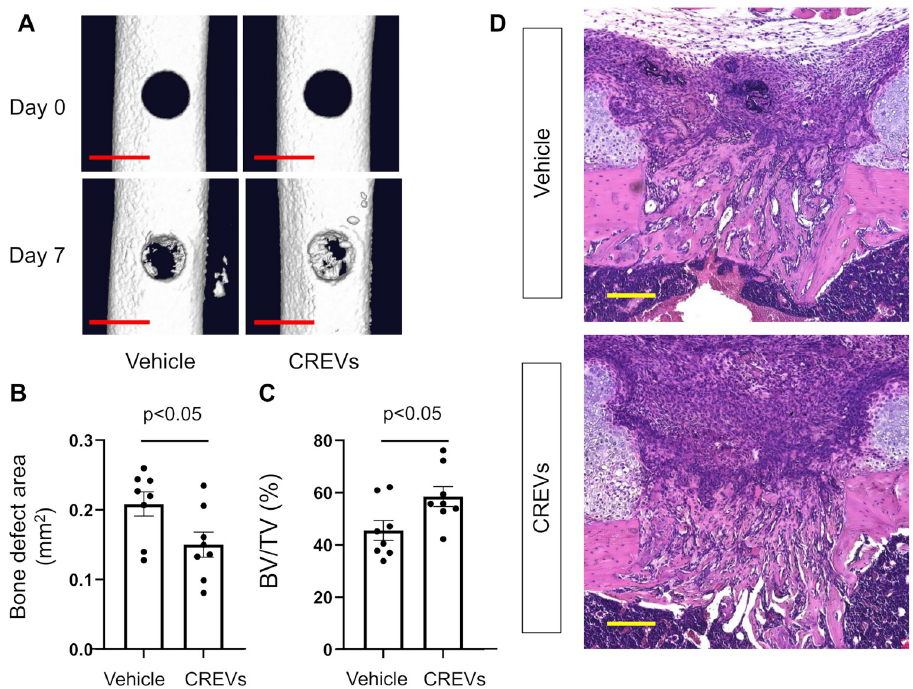
Fig 2. Effects of the local administration of CREVs on bone repair after a femoral bone defect. (A) Three- dimensional qCT images of damaged sites 7 days after a femoral bone defect. The scale bar indicates 1 mm. (B) The bone defect area at the damaged site 7 days after the femoral bone defect. (C) The bone volume/tissue volume (BV/TV, %) of mineralized bone that formed in the hole region 7 days after the femoral bone defect. Results are expressed as the means ± SEM of 8 mice per group. Statistical analyses were performed using the Mann–Whitney U test (B, C). (D) Images of HE-stained sections of damaged sites 7 days after the femoral bone defect. Scale bars indicate 200 μ m.